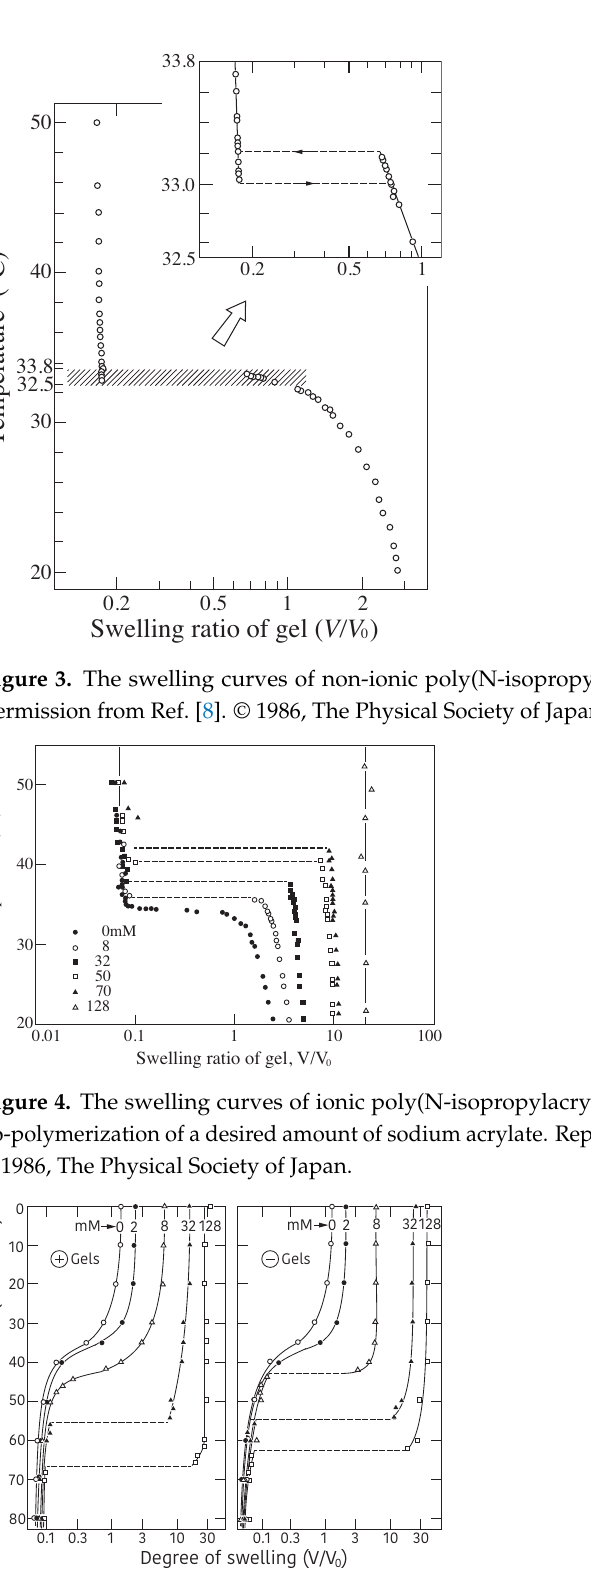
Figure 5. The swelling curves of positively charged gels and negatively charged gels. The desired amounts of (methacrylamidopropyl)trimethylammonium chloride is co-polymerized in the case of positively charged acrylamide gel. On the other hand, sodium acrylate is introduced into the polymer network of acrylamide by co-polymerization. Reproduced with permission from Ref. [8]. © 1986, The Physical Society of